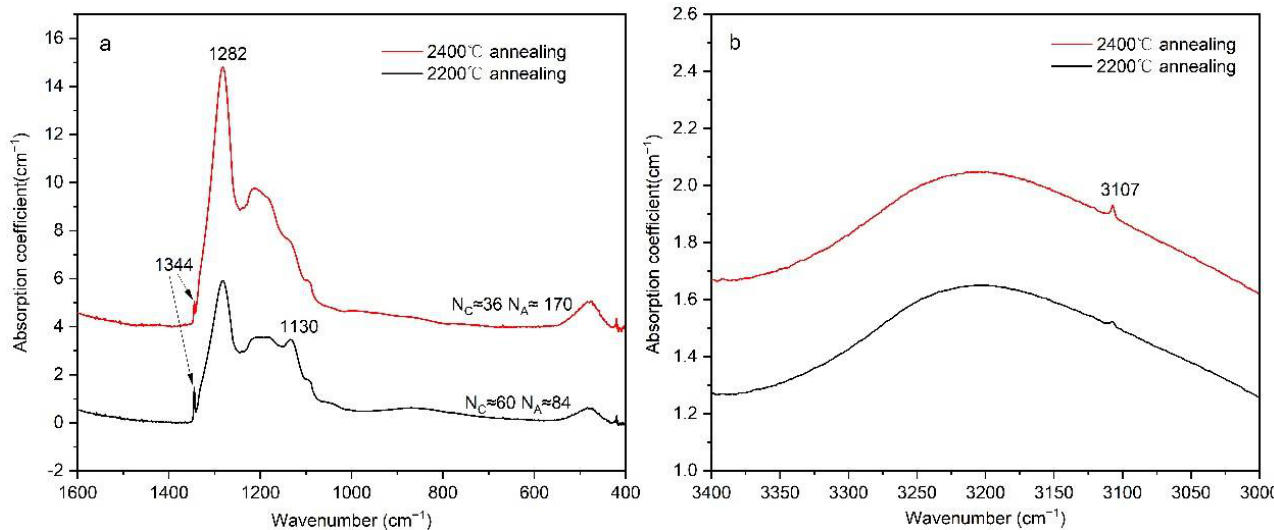
Figure 9. The 3107 cm −1 peak becomes stronger and stronger with the annealing temperature. With the A center content increase from 84 to 170 ppm ( a ), the 3107 cm −1 absorption coefficient increases from 0.02 cm −1 to 0.04 cm −1 ( b ).